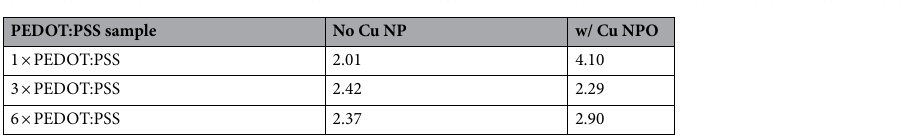
Table 5. rms surface roughness (SR) in [nm] of PEDOT:PSS films with multiple coatings with and without Cu NP doping.